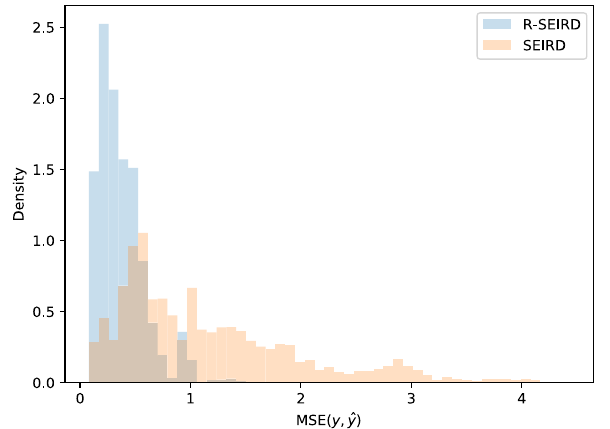
Figure 3. Comparison of prediction errors between R-SEIRD and SEIRD for the epidemic in the worst-hit county of each of the United States. We observe the errors of our model are substantially smaller than the canonical SEIRD model.